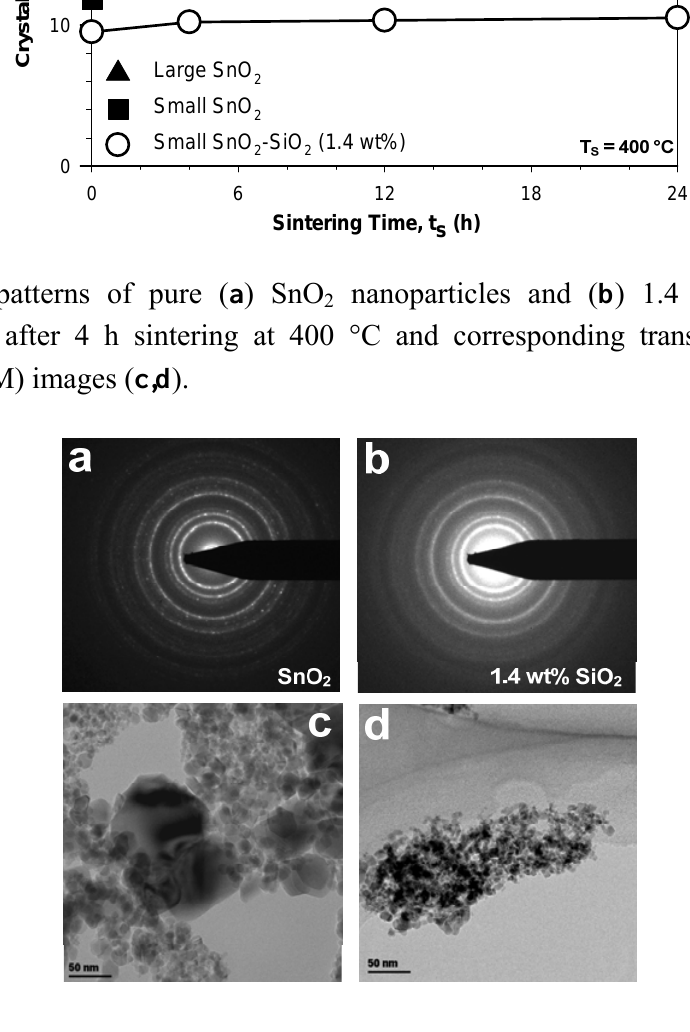
Figure 1. Average crystal size (d nanoparticles as a function of the sintering time at 400 °C. Cosynthesis of 1.4 wt% SiO (circles) drastically increased the long-term thermal-stability of SnO